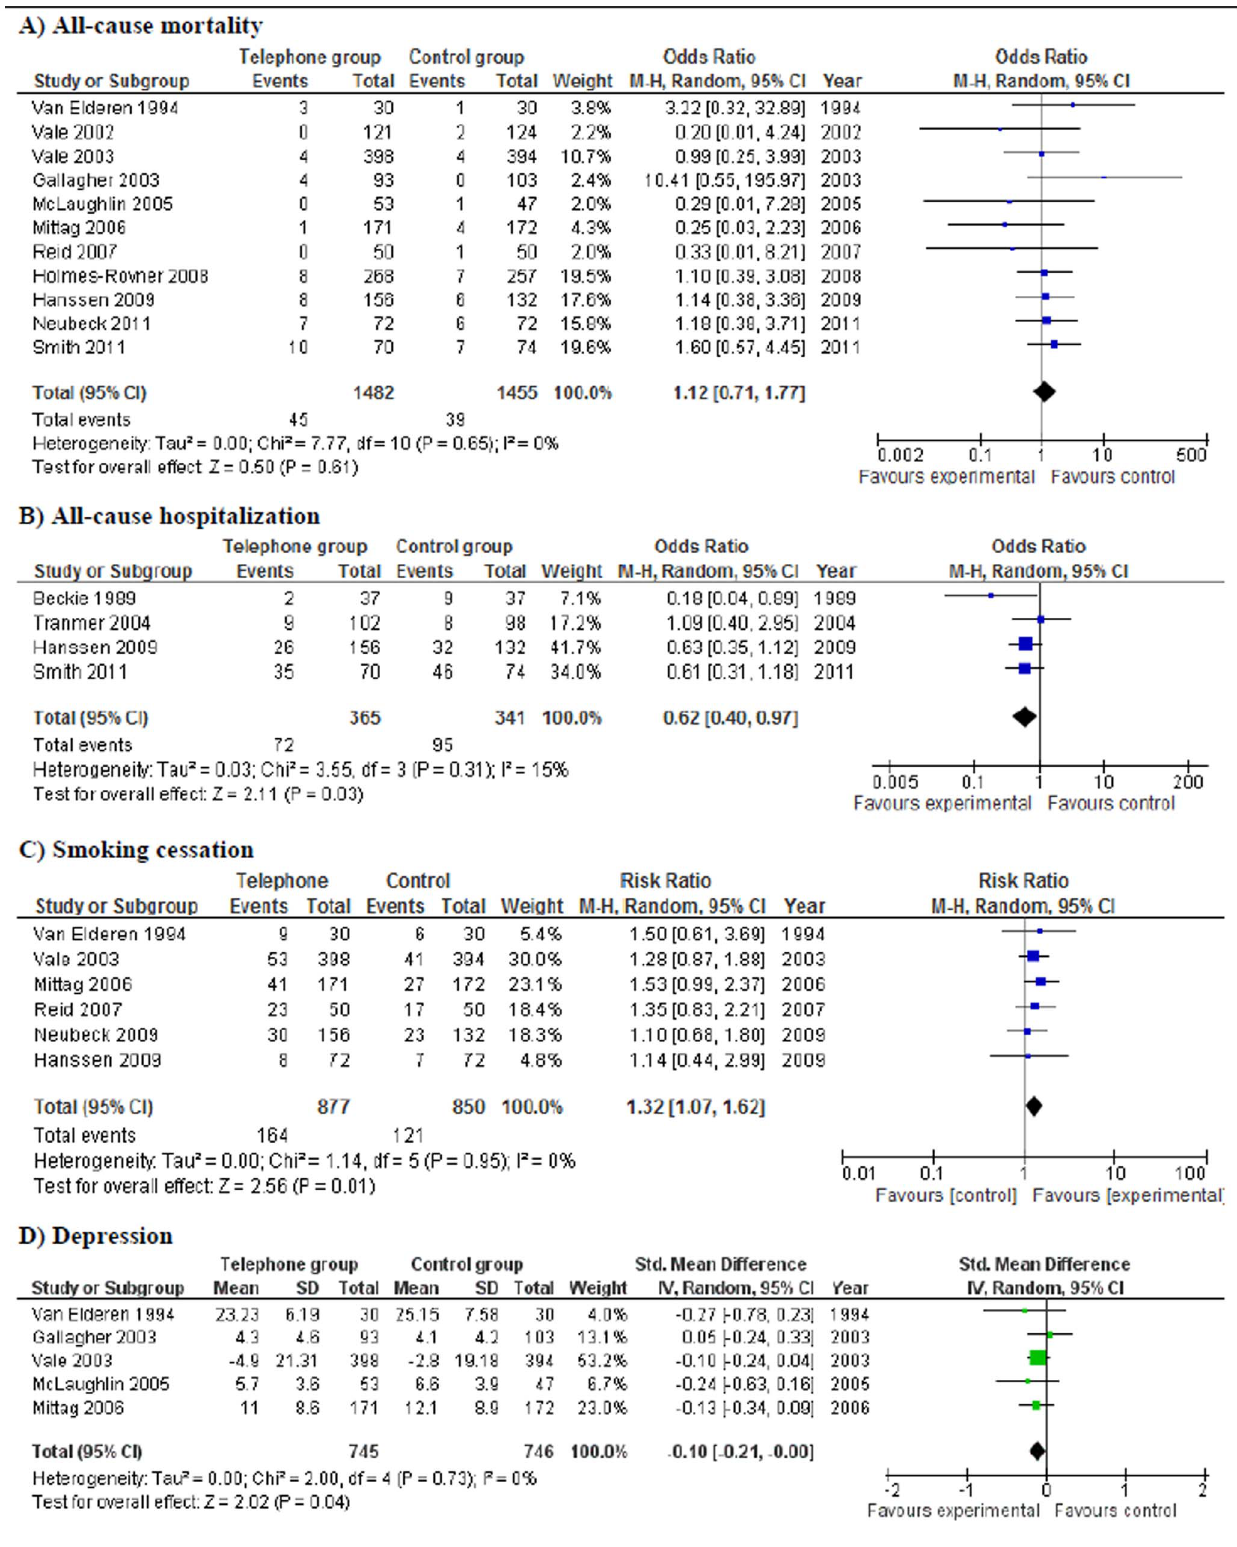
Figure 3. Comparing telephone support with usual care.